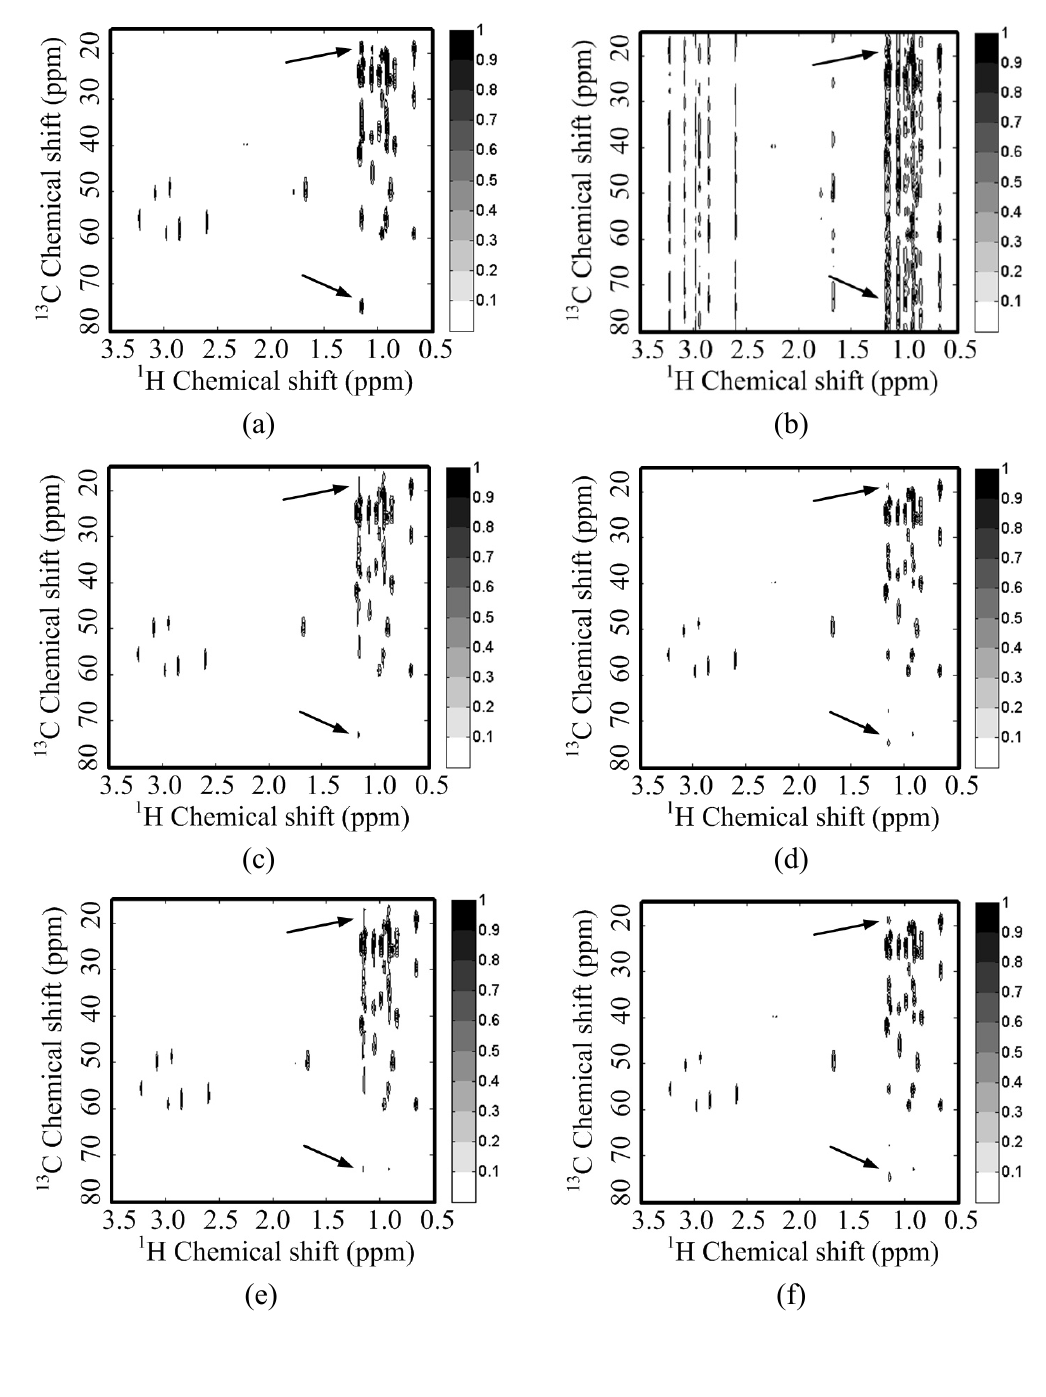
Figure 11. CS reconstruction of a 2D 1 H- 13 C COSY spectrum using wavelet and identity matrix. ( a , b ) spectra reconstructed using fully sampled FID ( N undersampled FID with zero filling, respectively; ( c , d ) spectra reconstructed using wavelets and identity matrix with IST-based ℓ reconstructed using wavelets and identity matrix with PSOCA-based ℓ ( g , h ) spectra reconstructed using wavelets and identity matrix with PSOCA-based ℓ norm,